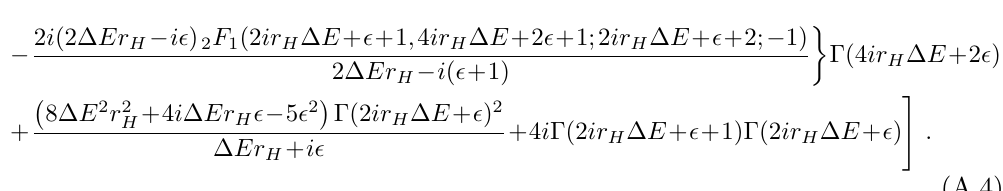
is plotted with respect to ω ε ωk